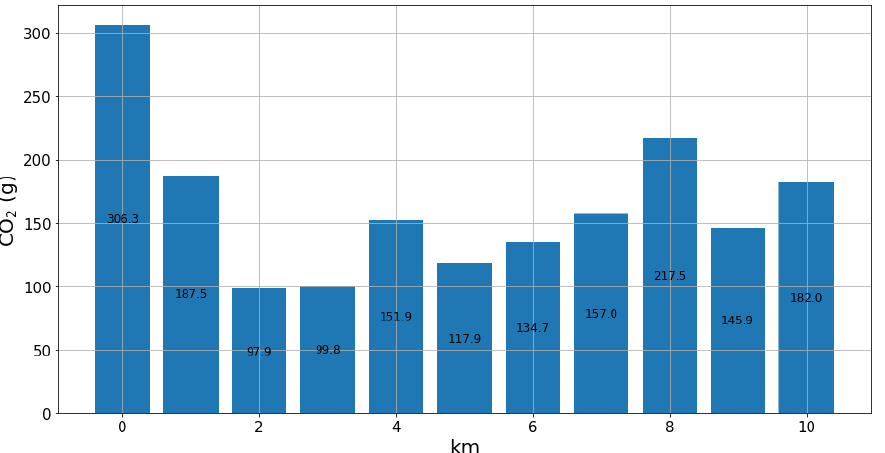
Figure 5. Mass of CO 2 (g) expelled by the vehicle per kilometer driven.